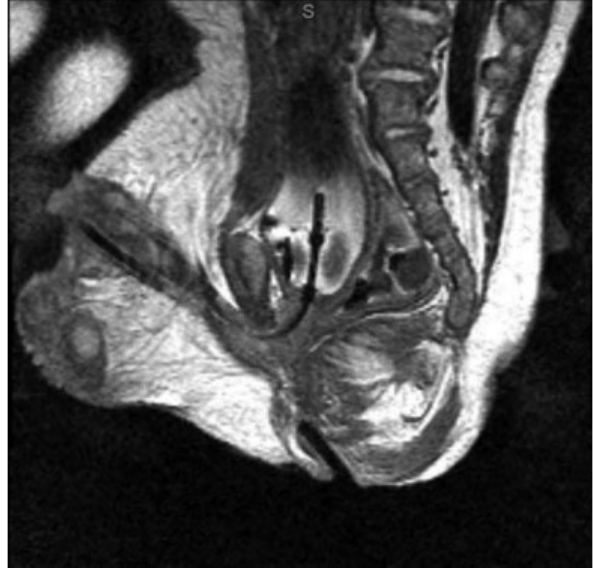
Fig. 3 Sagittal magnetic resonance image (MRI) showing the super fi cial sphincteranddeepsphinctercomplex,aswellasthelevatormuscles.Notea Foley catheter balloon within the bladder as well as an MR-compatible needle within the fi rst 1.5 cm of the sphincter